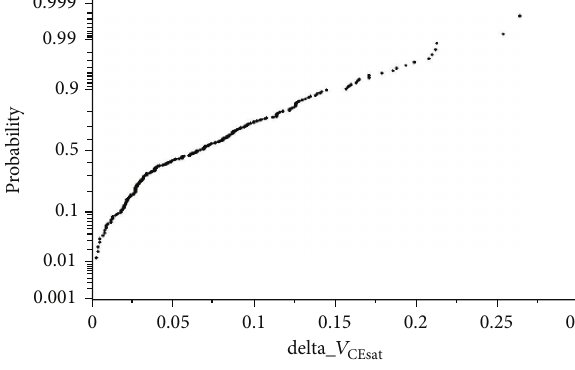
Figure 7: Differences in probability of 𝑉 CEsat .